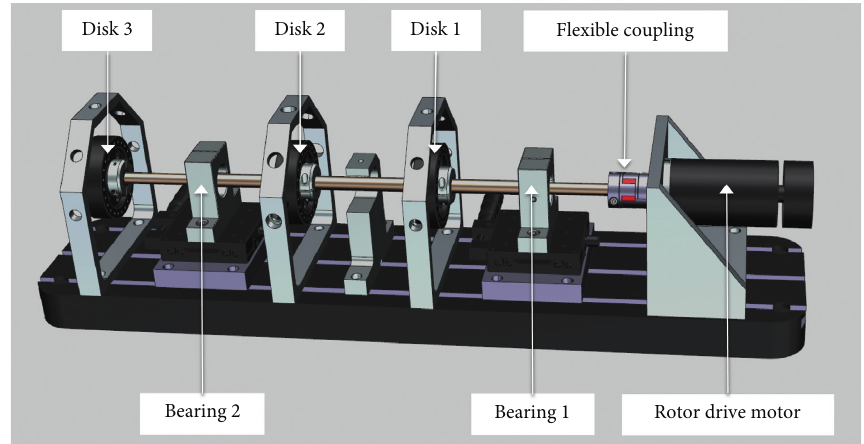
Figure 5: Bearing-rotor